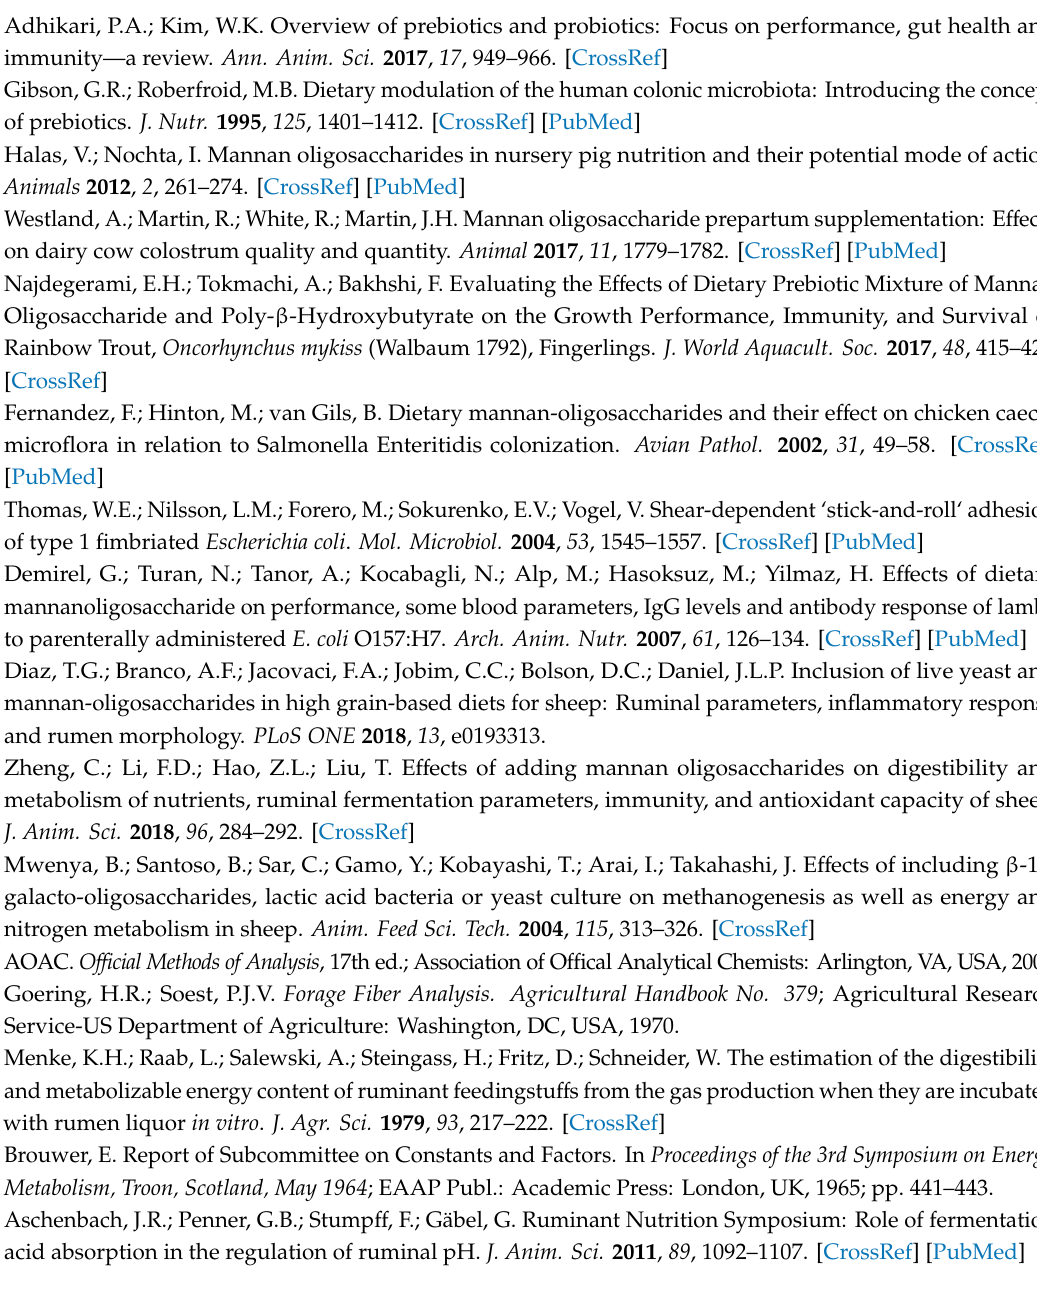
Table S1: Gas recovery rate by calibrating CO 2